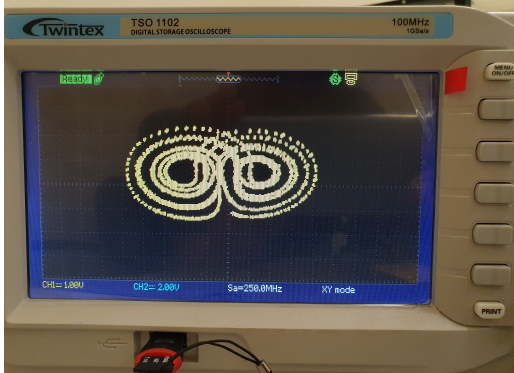
Figure 7. Acquired data from the uncontrolled slave system: ( a ) Projection on the plane ( x 1 , x 2 ). ( b ) Projection on the plane ( x 1 , x 3 ).